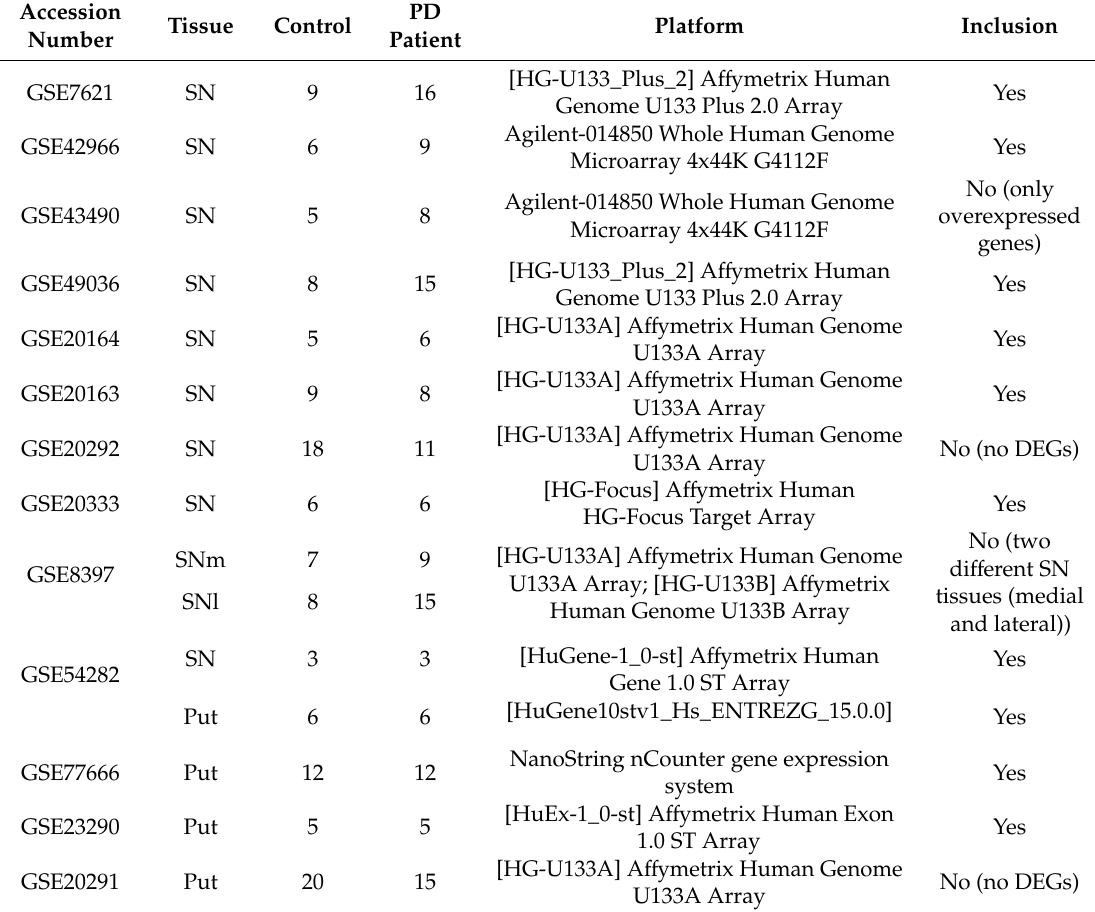
Table 2. Summary of publicly available transcriptomic studies on human postmortem substantia nigra (SN) and / or putamen from PD patients and